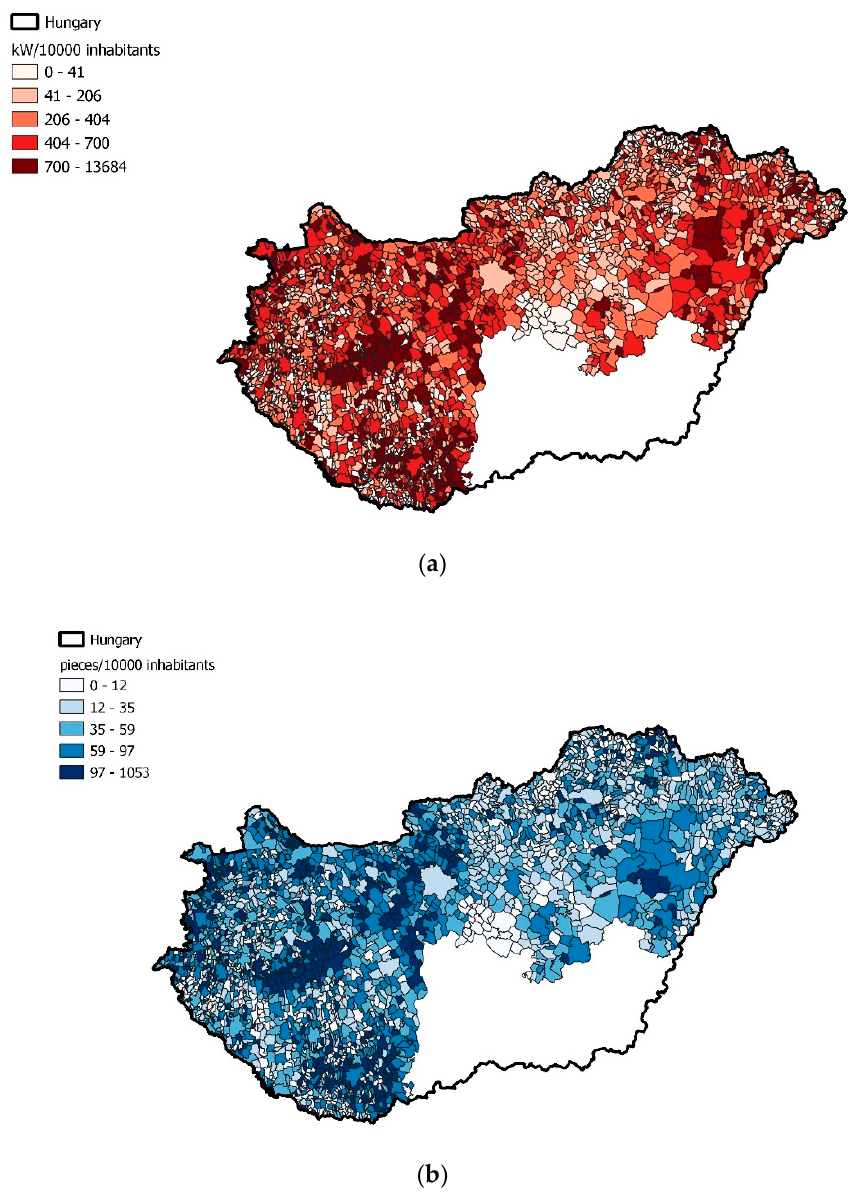
Figure 6. Total HMKE power ( a ) and the number ( b ) of HMKEs per 10,000 inhabitants in the settlements of Hungary.